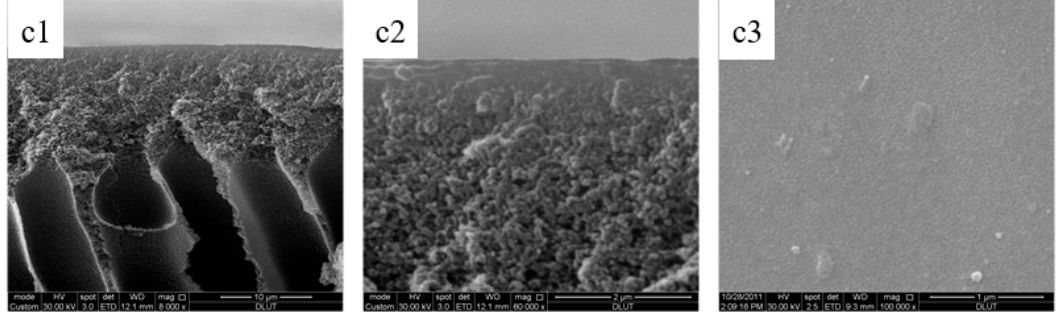
Figure 7. The morphologies of composite membrane. ( a1 , b1 , c1 ) are the cross sections of SPPES, SPPBES, and SPPHES, respectively, at 8000 × . ( a2 , b2 , c2 ) are the cross sections of SPPES, SPPBES, and SPPHES, respectively, at 60,000 × . ( a3 , b3 , c3 ) are the surface of SPPES, SPPBES, and SPPHES, respectively.